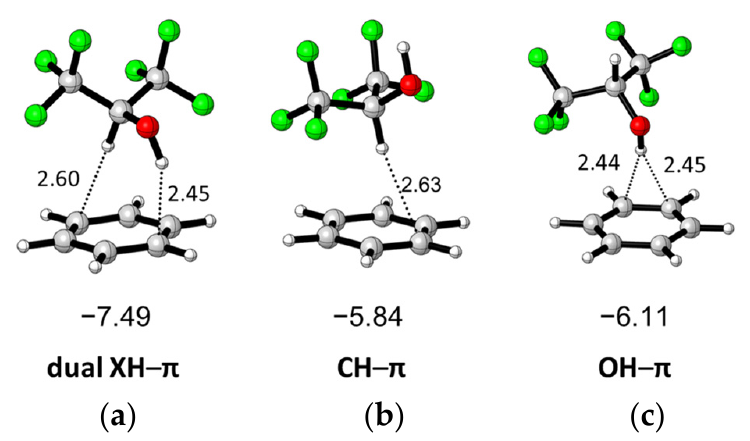
Figure 1. Three different optimized complexes of HFIP/PhH including ( a ) dual XH– π , ( b ) CH– π , and ( c ) OH– π interaction and their complexation energies (kcal/mol). The M06-2X/6-311++G(2d,2p)-level method was used in the geometry optimization of HFIP(SP)/PhH, CHCl 3 /PhH, and IP/PhH complexes, as concluded in Table 1. The electronic interaction energies of these complexes were also calculated with different meth- ods including counterpoise corrections to confirm the use of the M06-2X/6-311++G(2d,2p) method to be the suitable choice. Table 1. Electronic interaction energies (E int ), including counterpoise corrections.